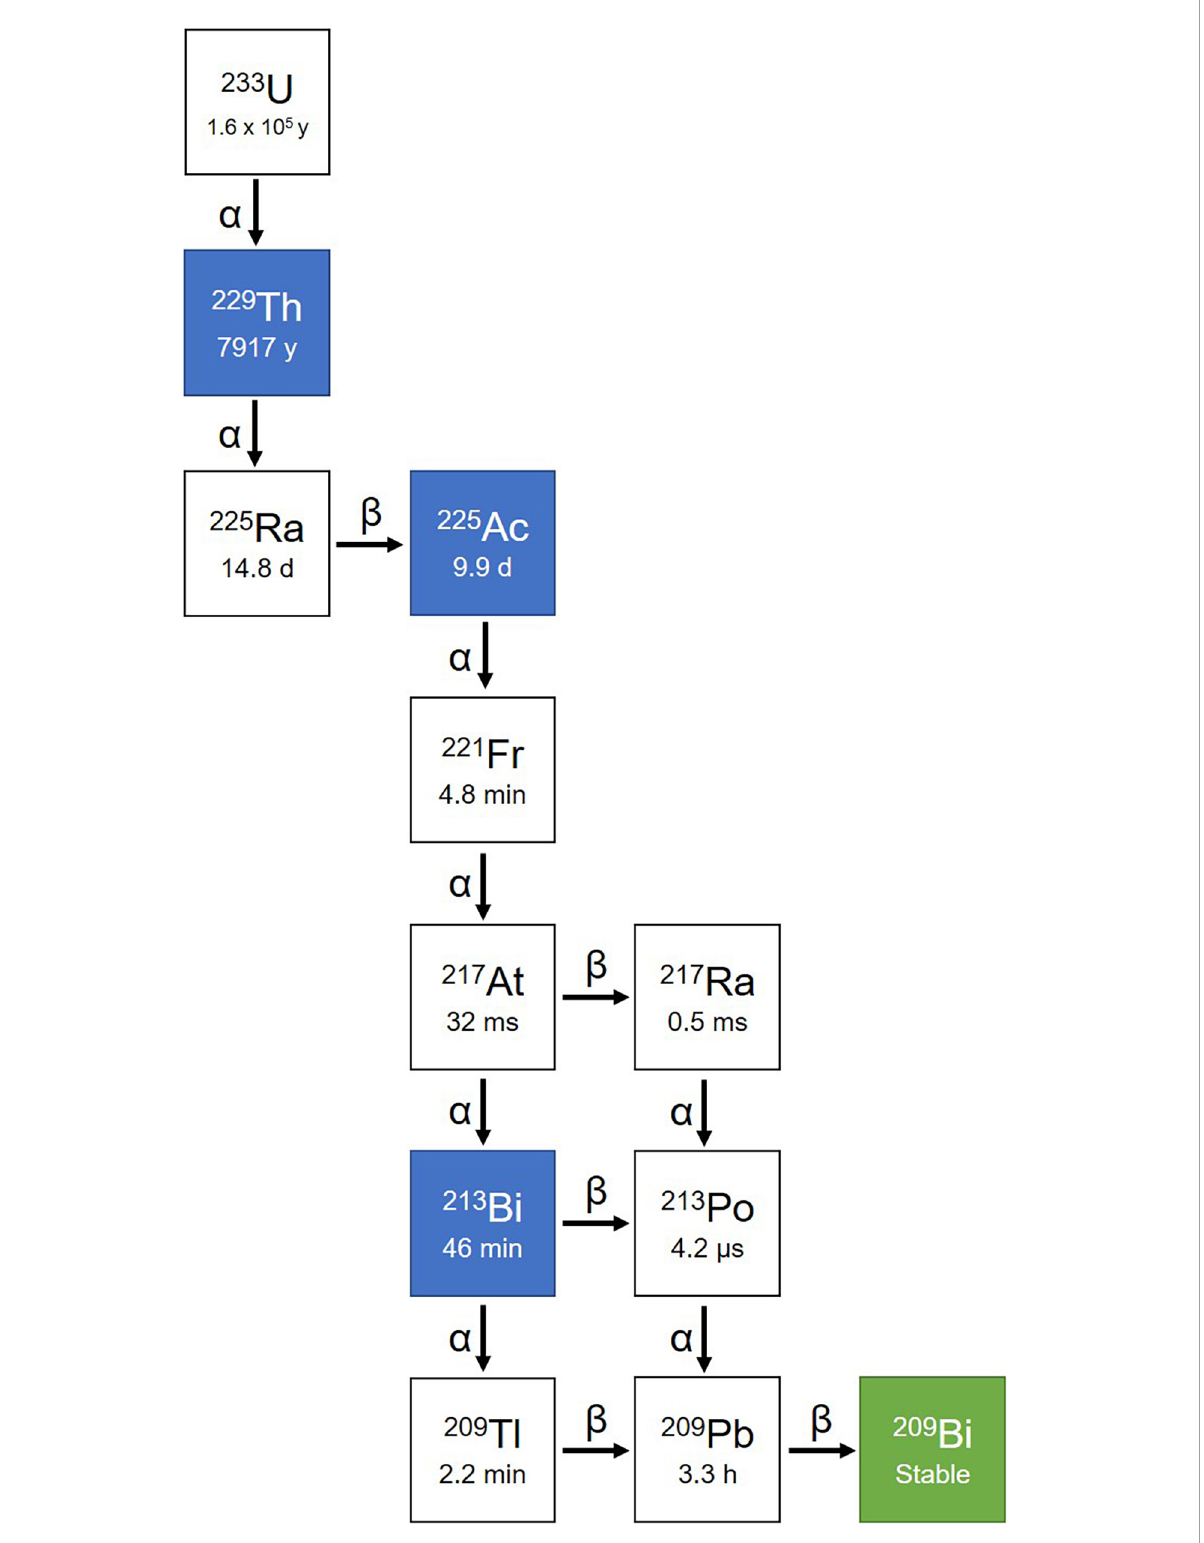
FIGURE4 Decay chain of 225 Ac. 225 Ac decays to 209 Bi with seven intermediate radionuclide progenies, including 221 Fr, 217 At, 213 Bi, 209 Tl, 217 Ra, 213 Po, and 209 Pb. Among the decay chain 225 Ac and 213 Bi are medically relevant and intensively